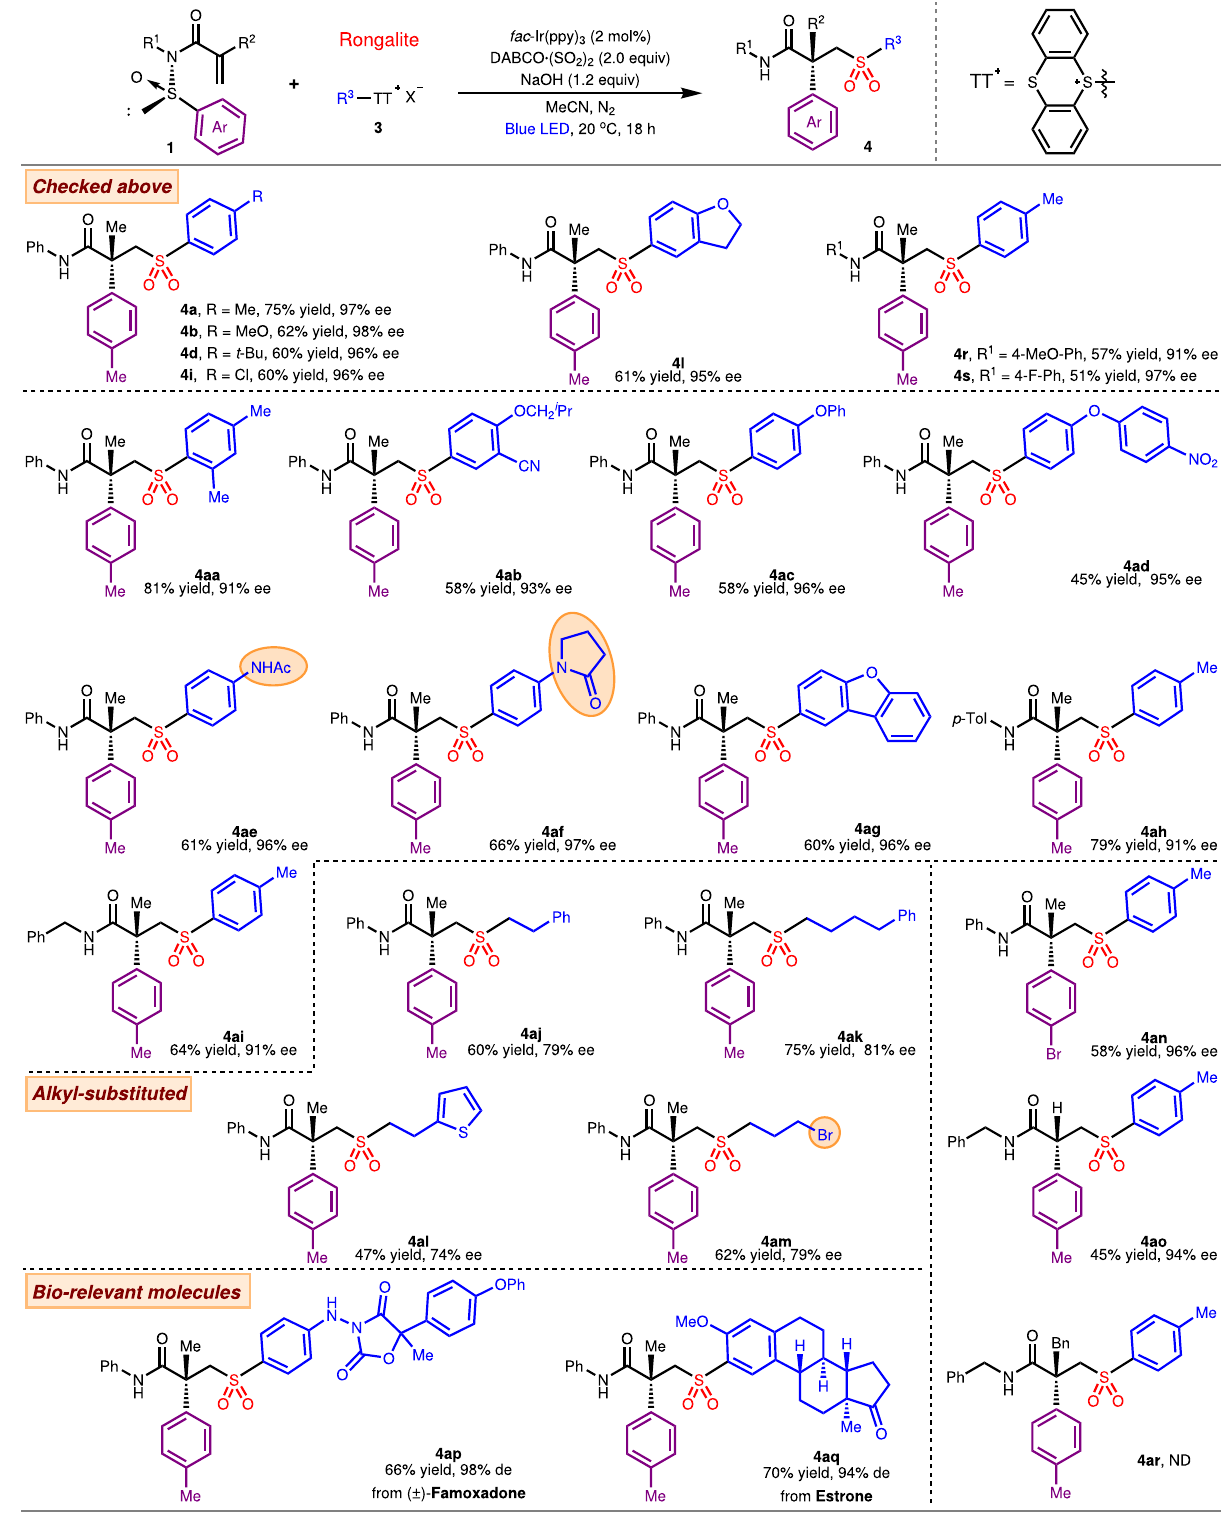
Fig. 3 | Generality of enantioselective Smiles rearrangement involving thian- threnium salts. Reaction conditions: 1 (0.2mmol), 3 (0.4mmol),